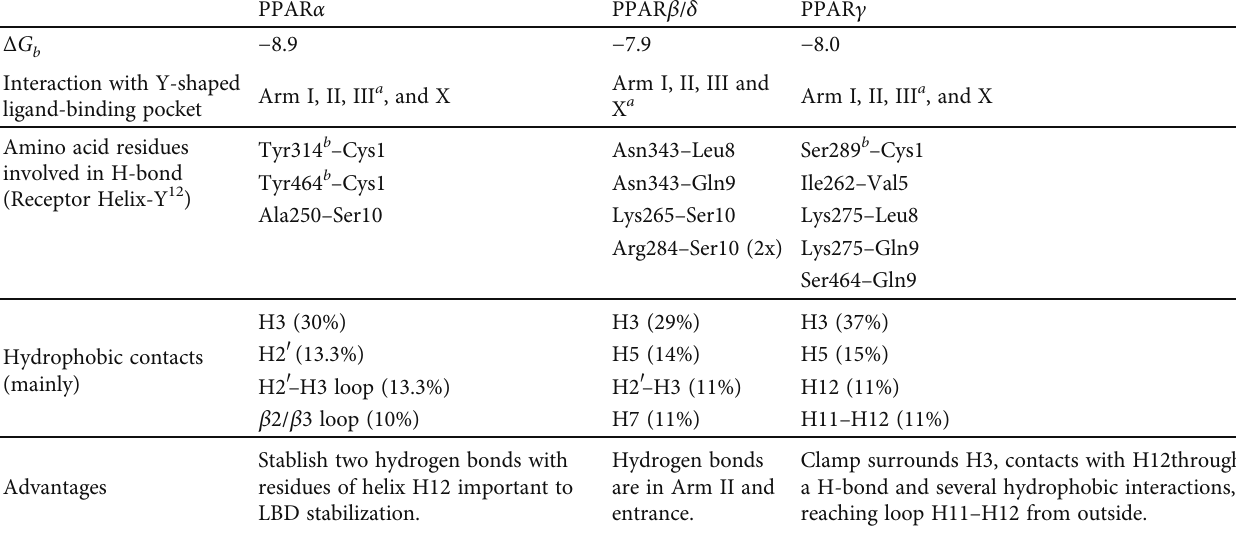
Table 2: Main characteristics of Helix-Y 12 interaction with